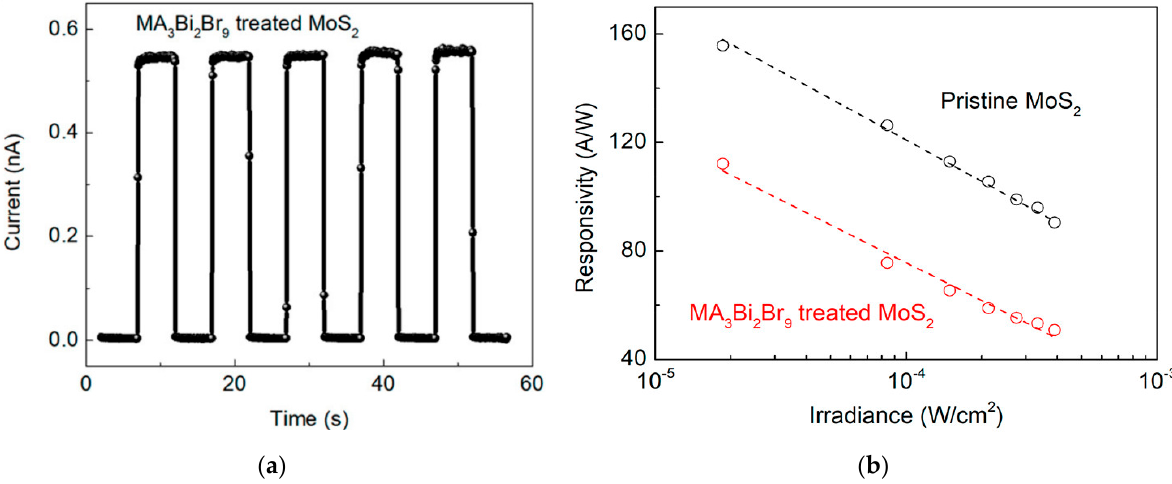
Figure 22. ( a ) Current measurements over time for a photoconductor based on MoS 2 and passivated with MA 3 Bi 2 Br 9 ; ( b ) Responsivity measures against irradiance for pristine MoS 2 and MoS 2 passivated with MA 3 Bi 2 Br 9 . Reprinted with permission from ref. [25]. © 2018, American Chemical Society.